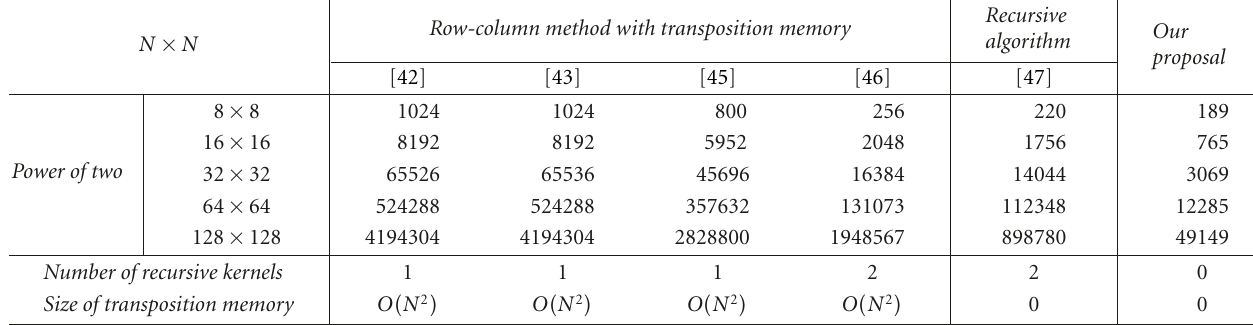
Table 15: Number of recursive cycles for di ff erent N × N DCT recursive structures.